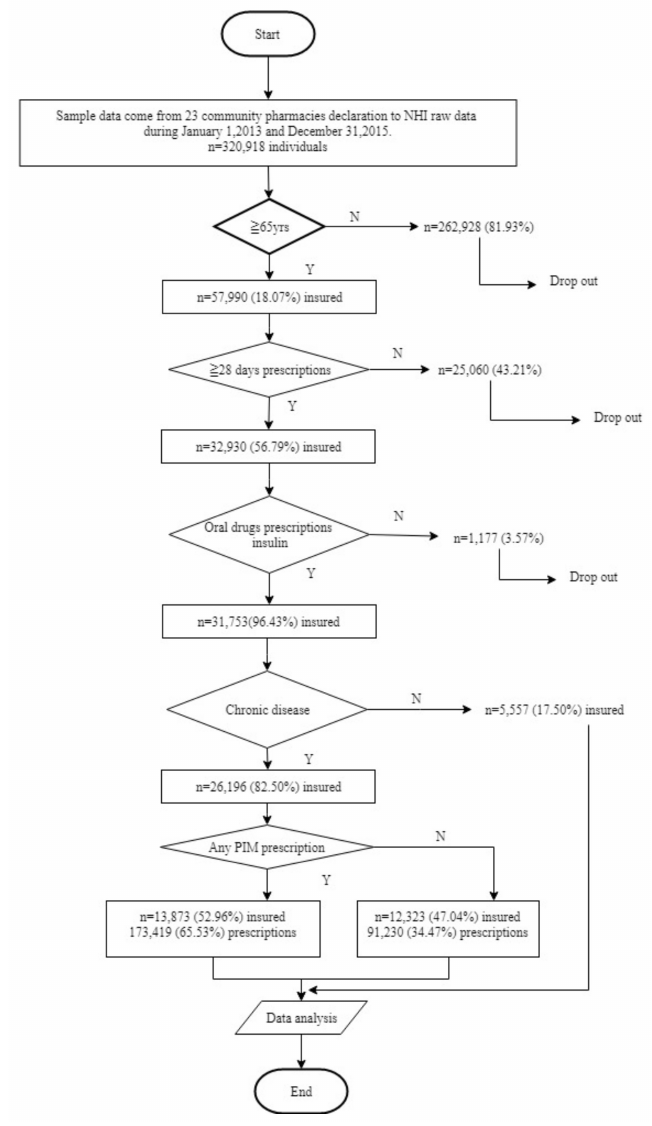
Figure 1. Flowchart of patient sample